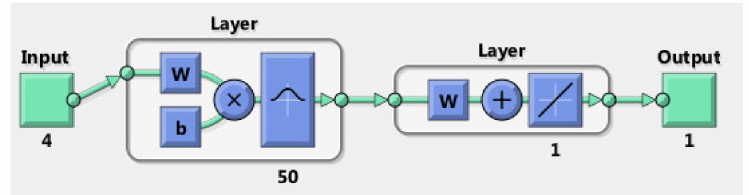
Figure 7. Architecture of Generalized Regression Neural Network (GRNN).